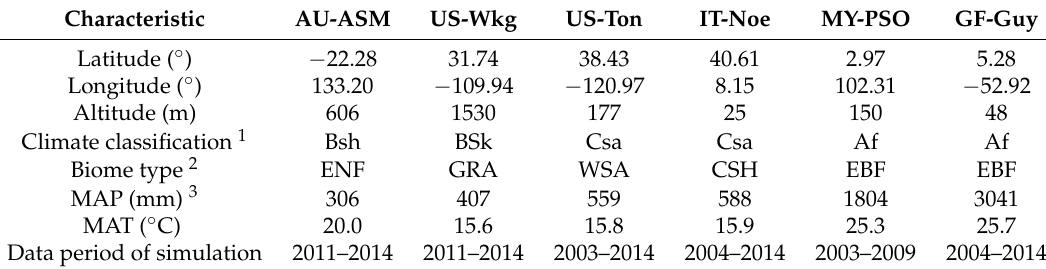
Figure 1. Location of the FLUXNET study sites: Alice Springs (AU-ASM) in Australia; Walnut Gulch Kendall Grasslands (US-Wkg) and Tonzi Ranch (US-Ton) in the United States; Arca di Noe-Le Prigionette (IT-Noe) in Italy; Pasoh Forest Reserve (MY-PSO) in Malaysia; and Guyaflux (GF-Guy) in French Guiana. Table 1. Main characteristics of the study